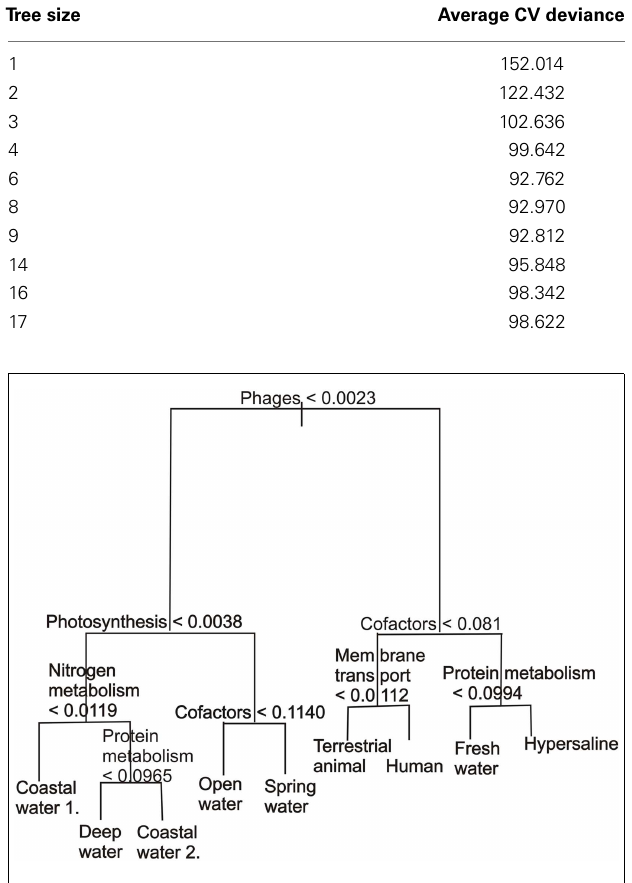
FIGURE 4 |A classification tree showing the separation of metagenomes from different environments based on the abundance of the subsystems in each environment. The abundances are normalized as described in the methods.The tree has been pruned to only show the eight most important